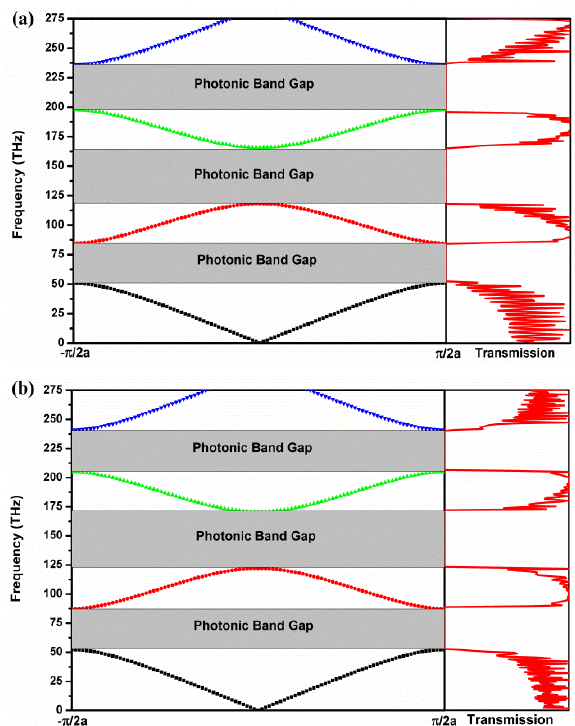
Figure 2: TE Band structure and transmittance spectra of BiTeCl (a) and SbSBr (b) in 1D.